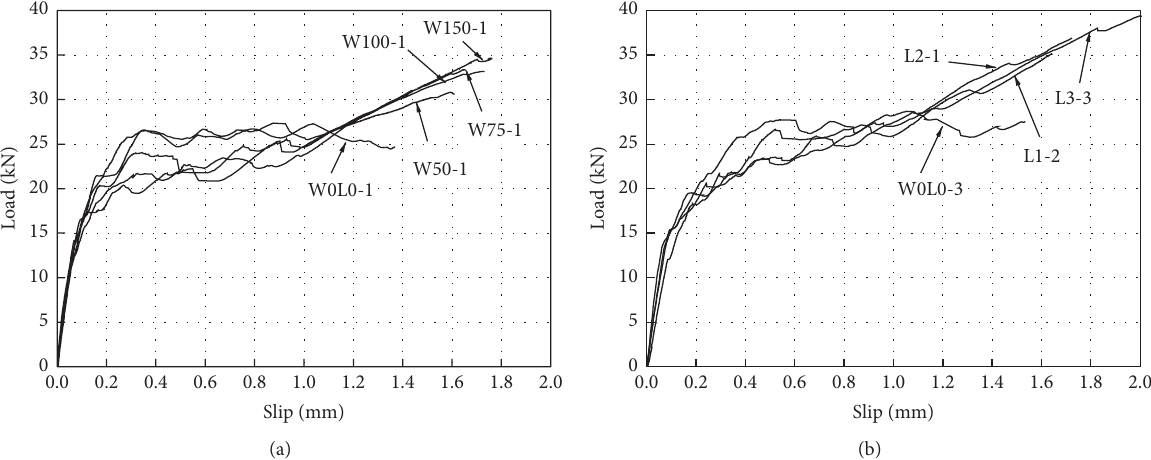
Figure 6: Experimental load-slip curves of specimens. (a) W series and control specimens. (b) L series and control